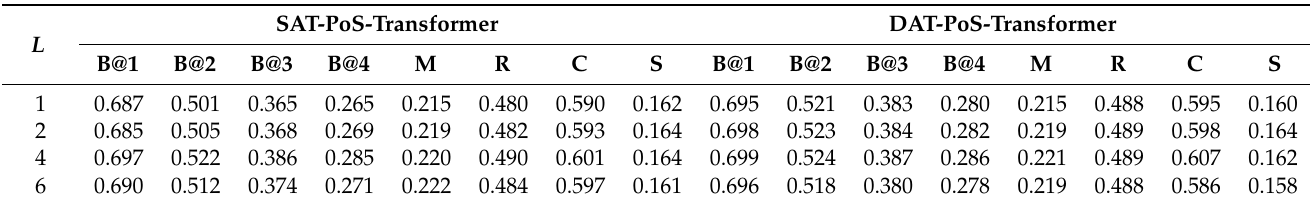
Table 1. The performance of PoS-Transformer with different numbers of encoding and decoding